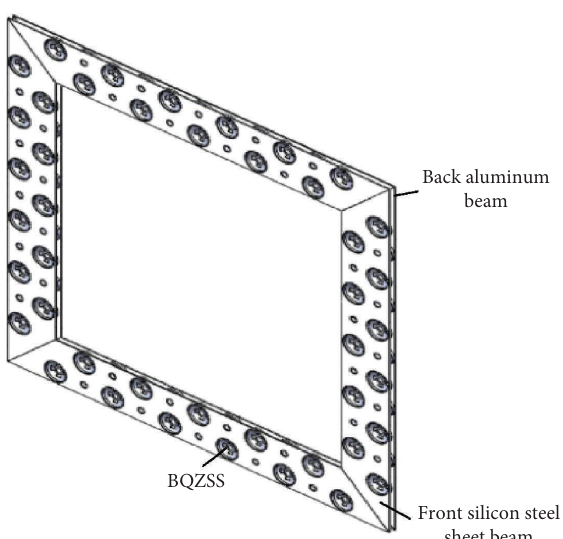
Figure 2: Double-beam